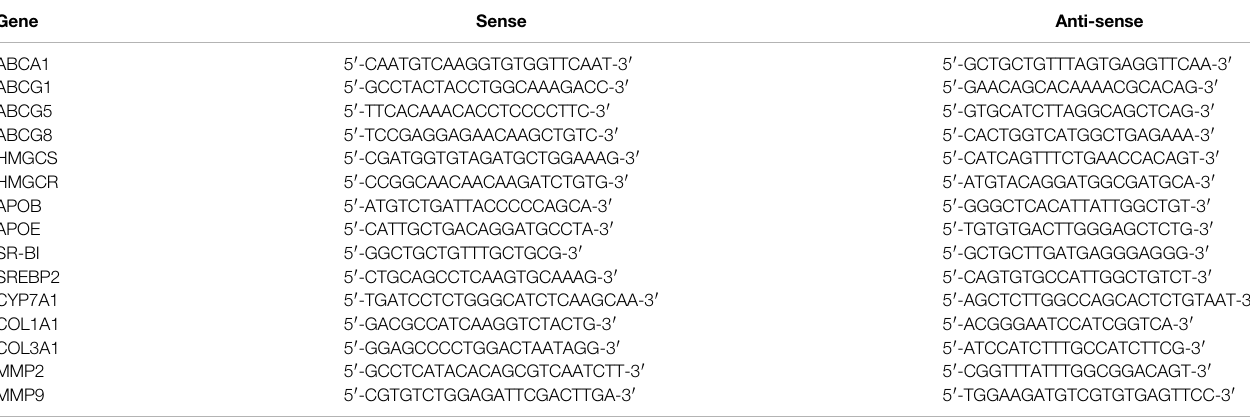
TABLE 1 | Sequences of primers for